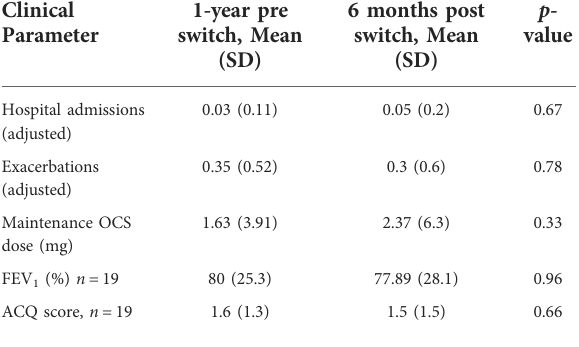
TABLE 1 Comparing the mean values of the fi ve clinical parameters measured in this study 1 year before switching from reslizumab to either benralizumab or mepolizumab to the mean values of the same parameters 6 months after switching. TABLE 2 Comparing the mean values of the